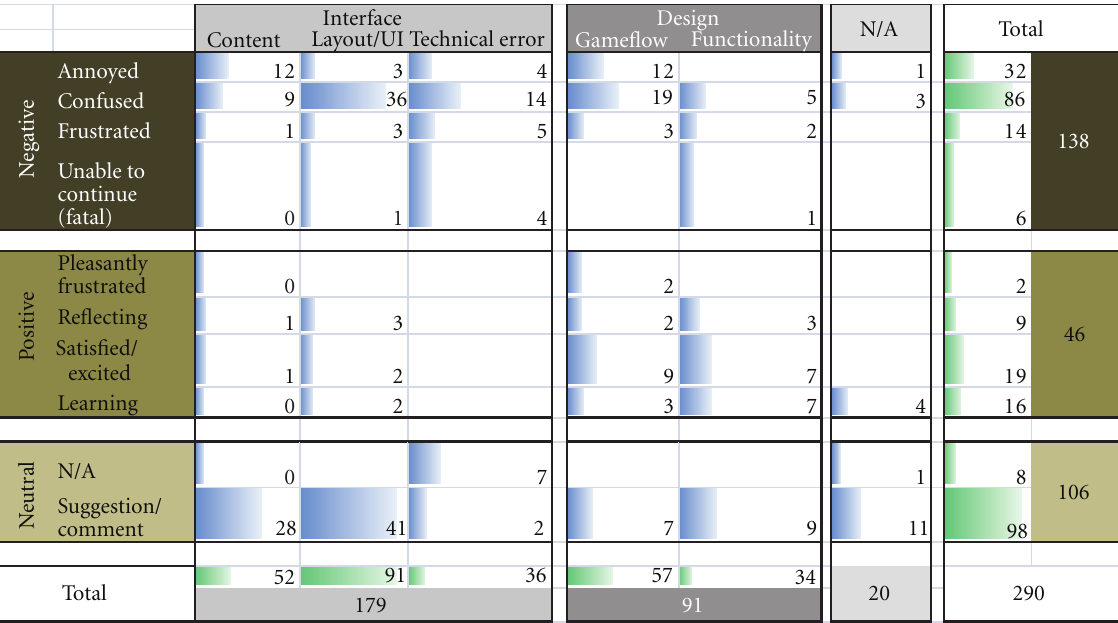
Figure 3: Tag statistics: the events are categorized on two dimensions: the source of the event (interface, design) and the reaction of the